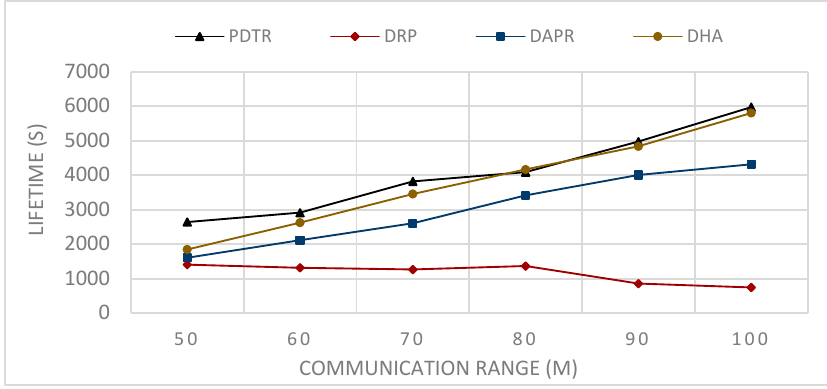
Figure 10. Impact of varying the communication range on the network lifetime.